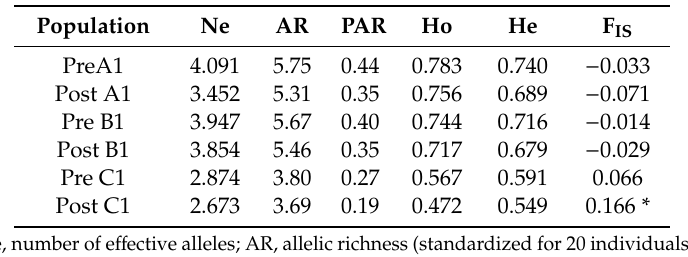
Table 4. Three large Pistacia chinensis populations divided into six pre- and post-fragmentation populations showing genetic diversity.